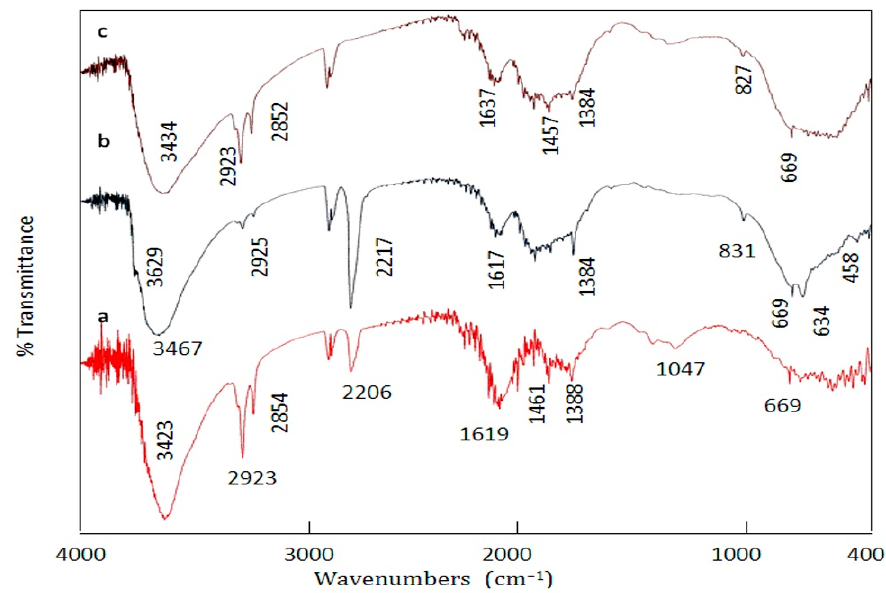
Figure 7. FT-IR spectra of: ( a ) CSHDS, ( b ) CSLDH-1, and ( c ) CSLDH-2.